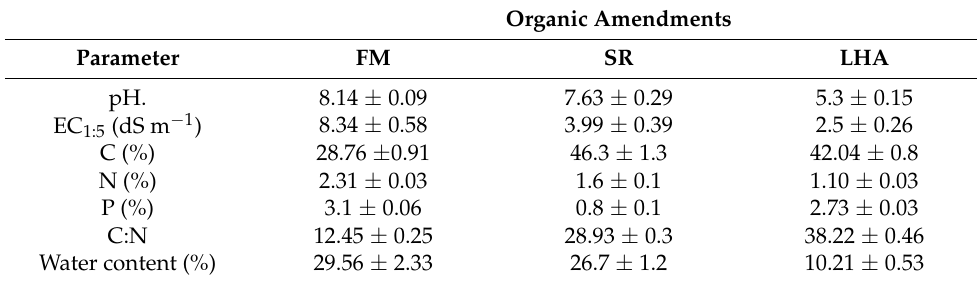
Organic Amendments